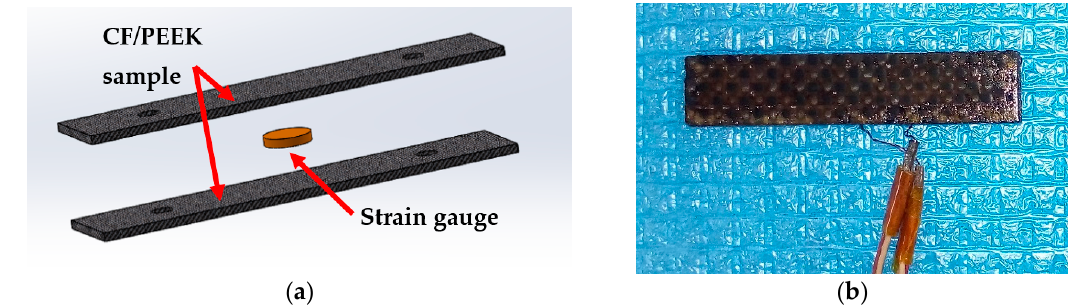
Figure 4. Strain gauge assembly. ( a ) Exploded view of a MM sample with the strain gauge thermally welded between two pieces of CF/PEEK; ( b ) MM sample after completion of thermal welding process.